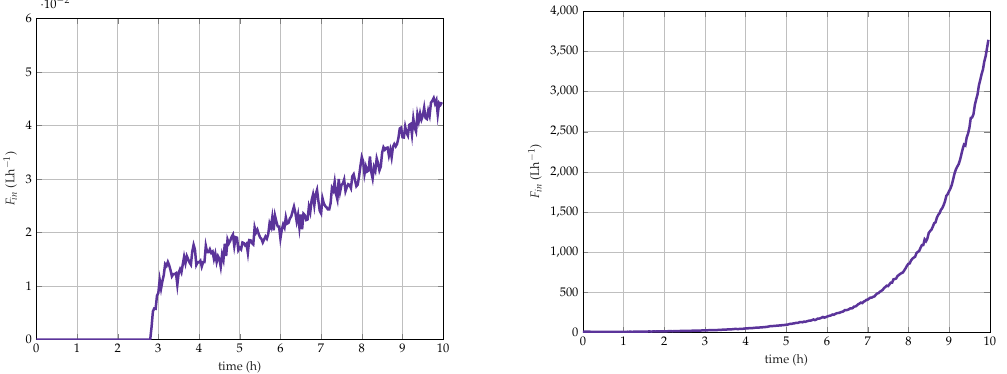
Figure 7. Flow rate evolution: full-order model ( Right ) and reduced model ( Left